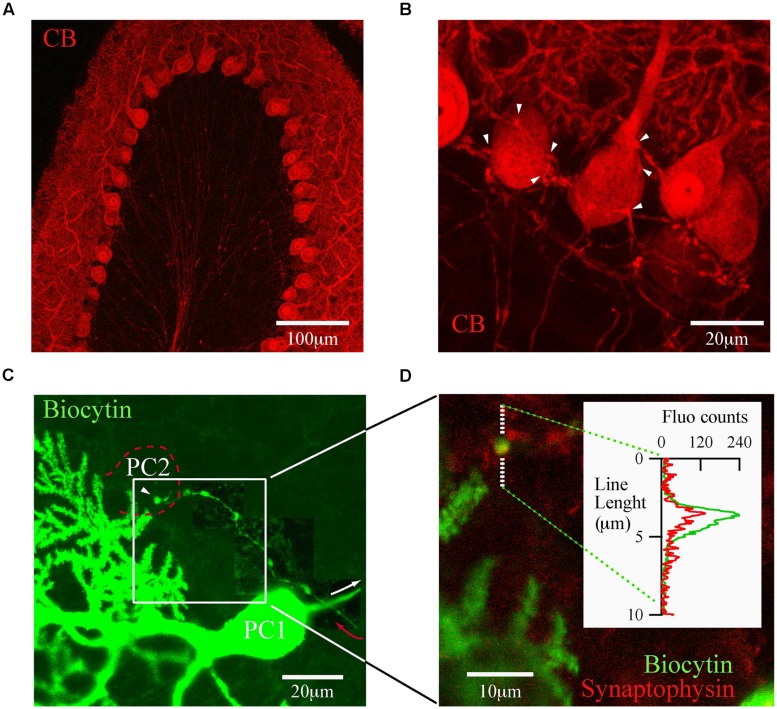
calbindin D-28k labels presynaptic PC collateral boutons onto neighbor PC. (A) Confocal image of a cerebellar lobule showing that in the cerebellar cortex, CB expression is restricted to PC (PN18, sagittal slice). (B) At high resolution, CB labels the recurrent axon collateral plexus and their boutons on PC somata (white arrowheads). (C) Confocal image of one biocytin-filled PC (PC1; green)) in which the main axon (white arrow) gives rise to a recurrent collateral that returns to the PC layer (red arrow) and terminates on a neighbor PC soma (PC2, dotted red line). To reveal the axon collateral, the contrast was adapted for three adjacent areas of the final stack. (D) Zoom of the white square in (C) shows a biocytin-loaded bouton (green) on the PC layer (white square) co-localizing with synaptophysin (red). Line analysis (inset) confirmed that boutons on PC layer are bona fide PC–PC synapses.